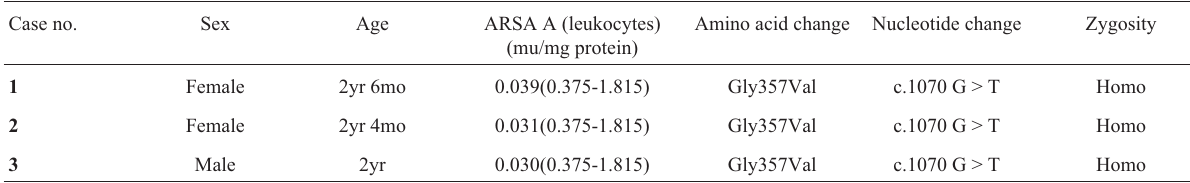
Table 1 - Leukocyte ARSA A level and mutational analysis of ARSA Case no.